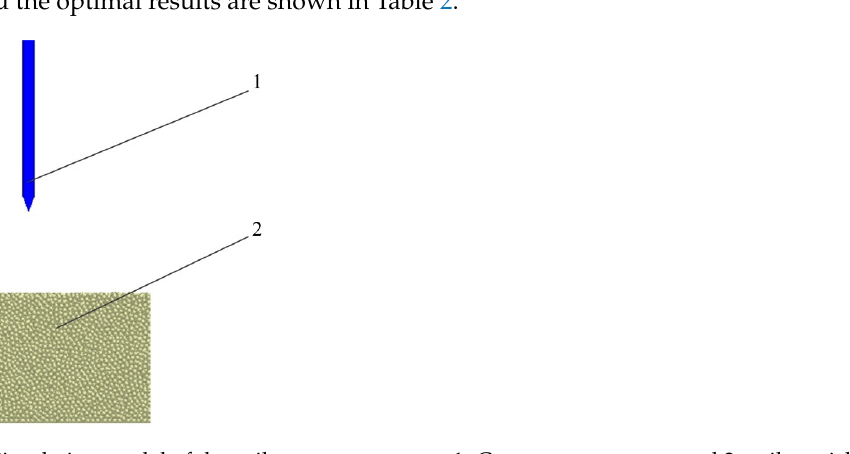
Figure 5. Simulation model of the soil compactness test. 1. Compactness meter, and 2. soil particles. Table 2. HWB model’s calibration values.